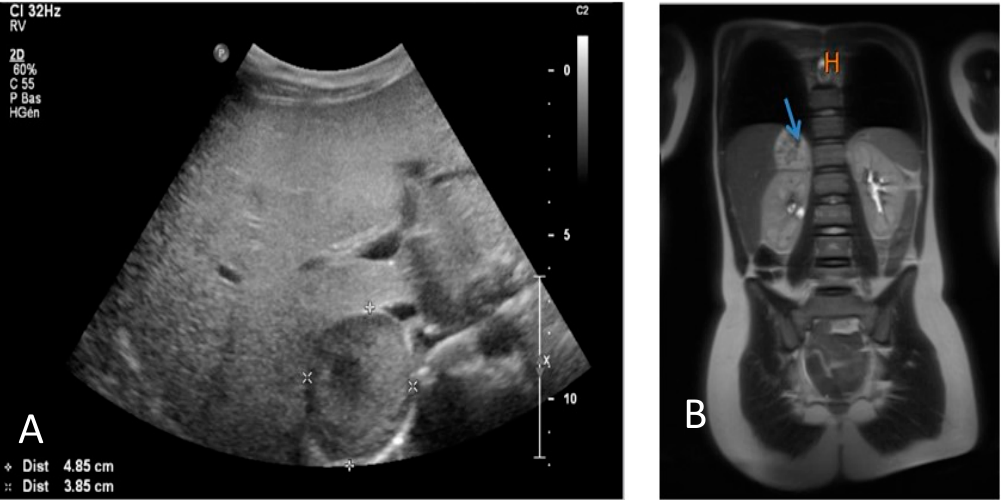
Figure 2. Echocardiographic modified long axis view with focus on the aortic root. The aortic root inner diameter in systole is 29 mm (Z-score: 2.5).